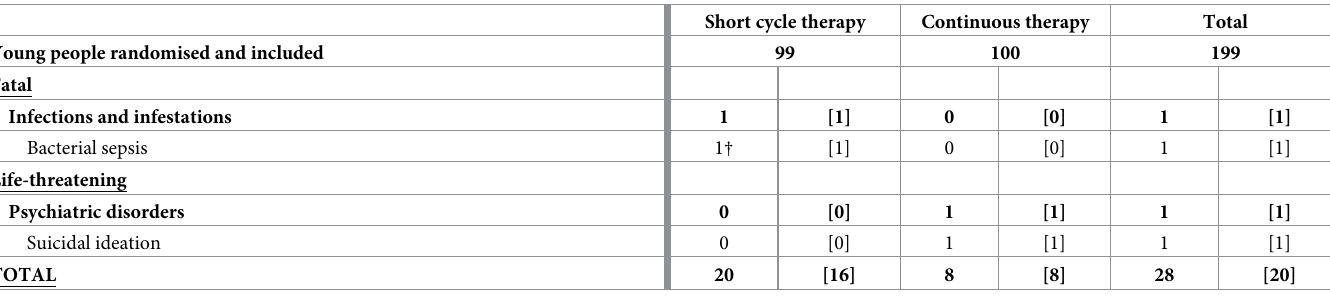
S1 Table. Centres participating in the BREATHER